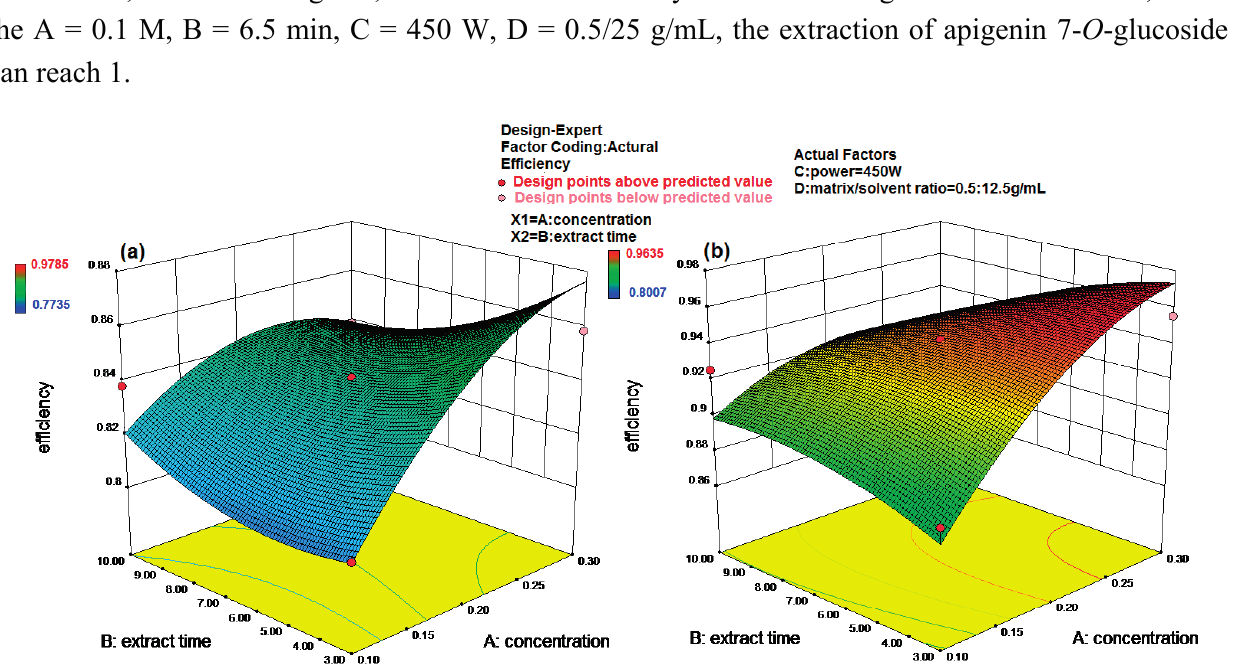
Figure 9. Response surface plots showing the effects of variables on extraction efficiency of two indicator compounds. ( a ) Luteolin 7- O -glucoside; ( b ) Apigenin 7- O